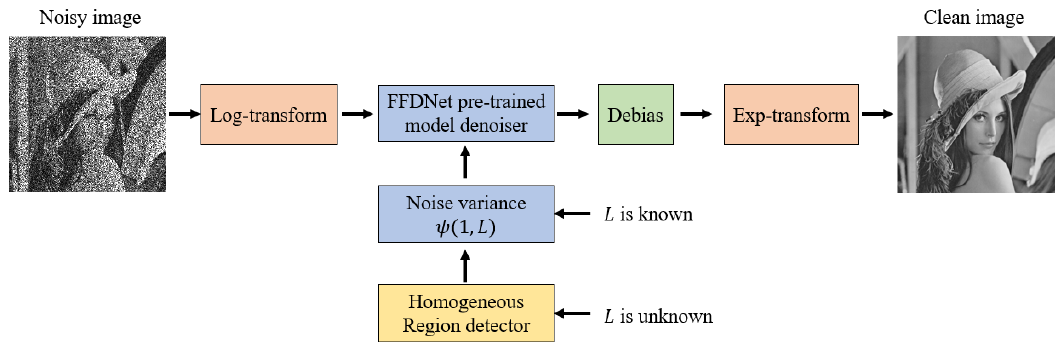
Figure 2. The framework of Homo-FFDNet filter for SAR